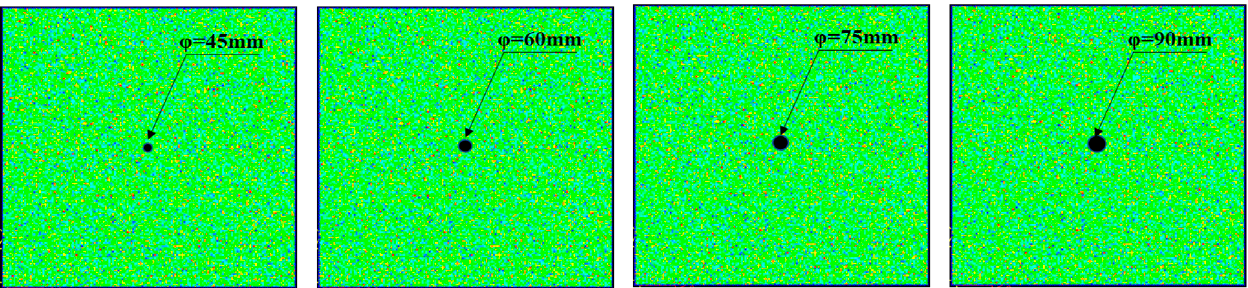
Figure 10. Numerical calculation model of different fracturing apertures.